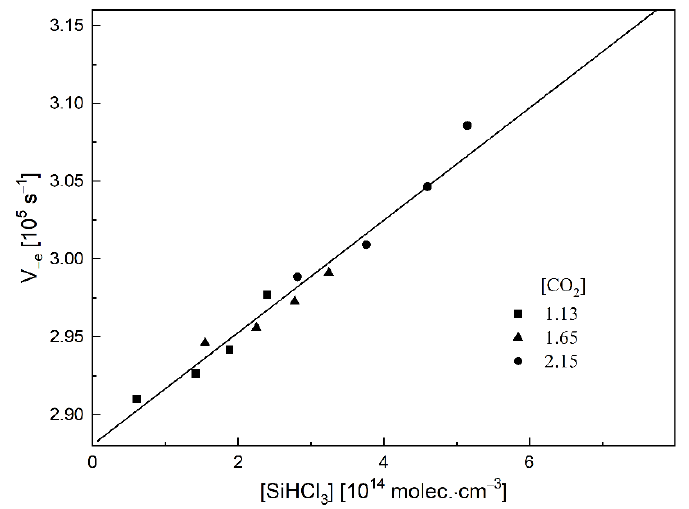
Figure 2. The rate of electron disappearance for SiHCl 3 as a function of halogenated silane concen- tration at a three different CO 2 concentrations [10 19 molec. · cm − 3 ].